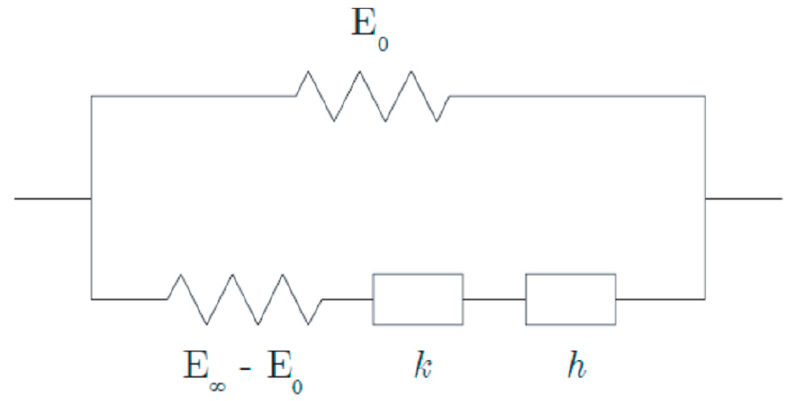
Figure 6. Huet–Sayegh model [22].